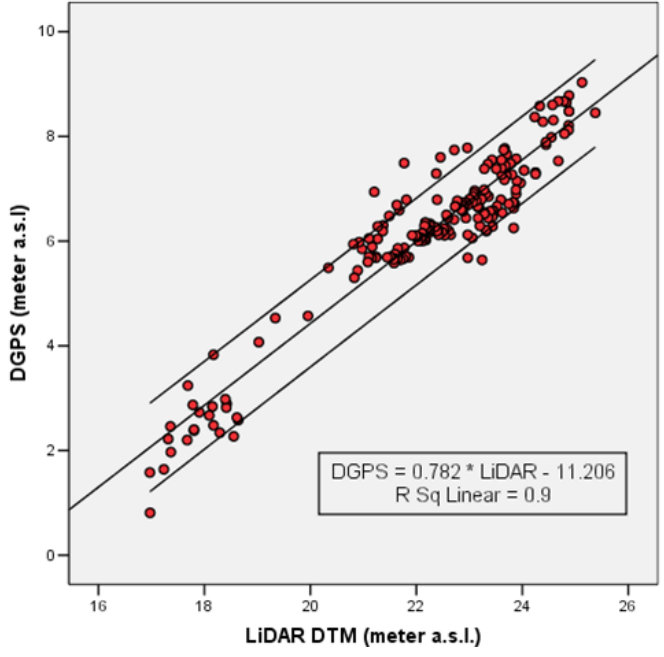
Figure 3. Correlation of the airborne LiDAR derived DTMs and the Differential Global Positions System (DGPS) points collected in the field (R 2 = 0.9, n = 201). Also shown are the 95% confidence